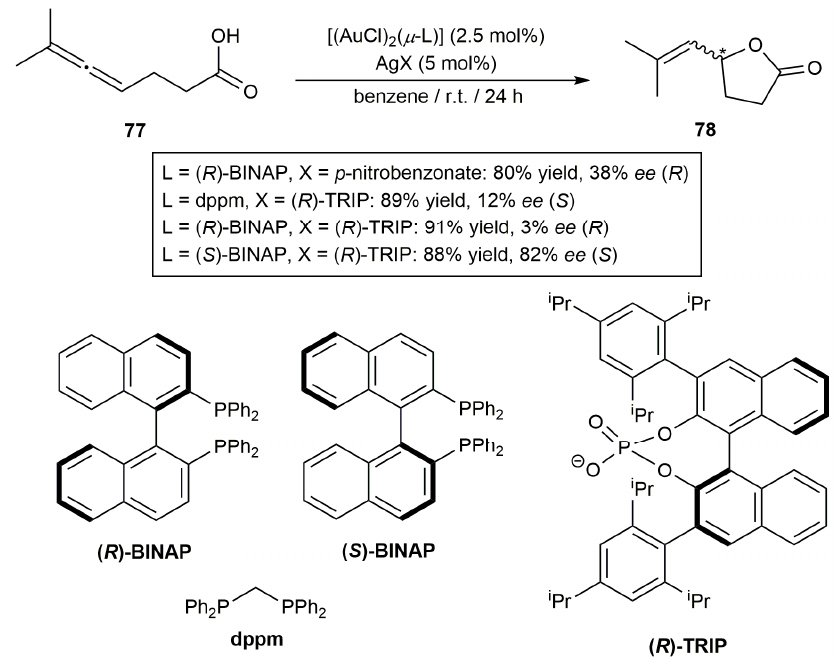
Scheme 34. Gold-catalyzed enantioselective cyclization of the γ -allenoic acid 77 .